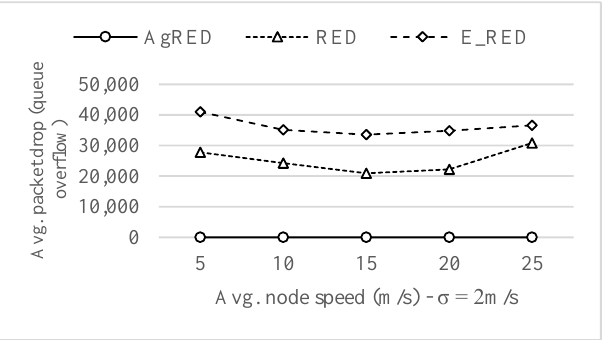
Figure 10. Average packets dropped due to queue overflow in UDP vs. Average node speed.